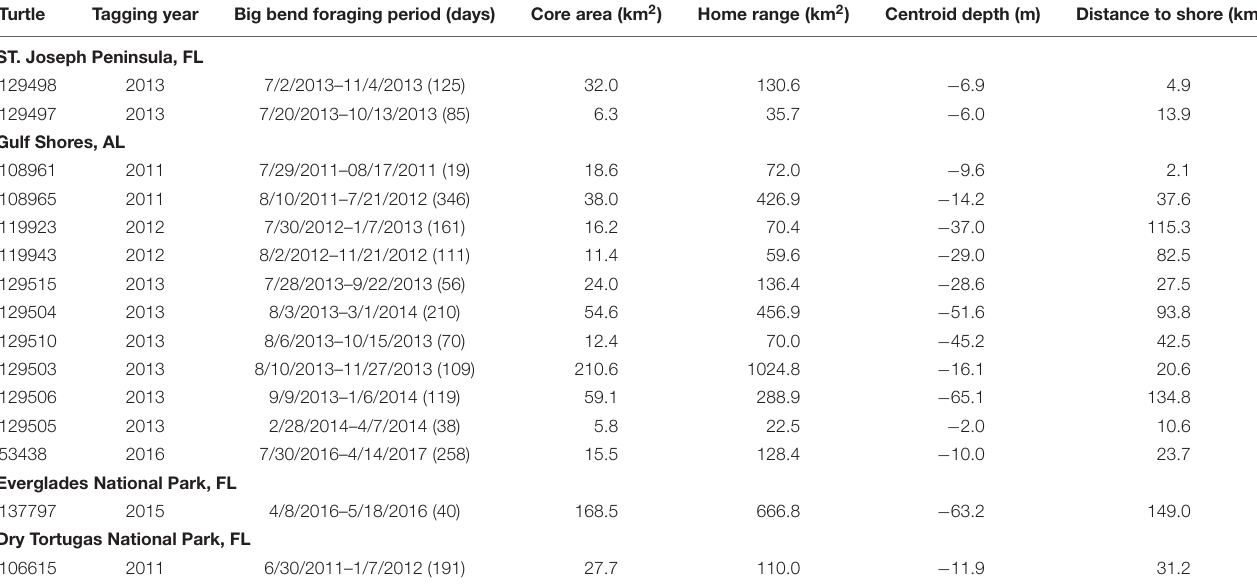
TABLE 1 | Tagging and kernel density estimate (KDE) details for adult female loggerheads with resident foraging areas in the Big Bend region. Turtle Tagging year Big bend foraging period (days) Core area (km 2 ) Home range (km 2 ) Centroid depth (m) Distance to shore (km)